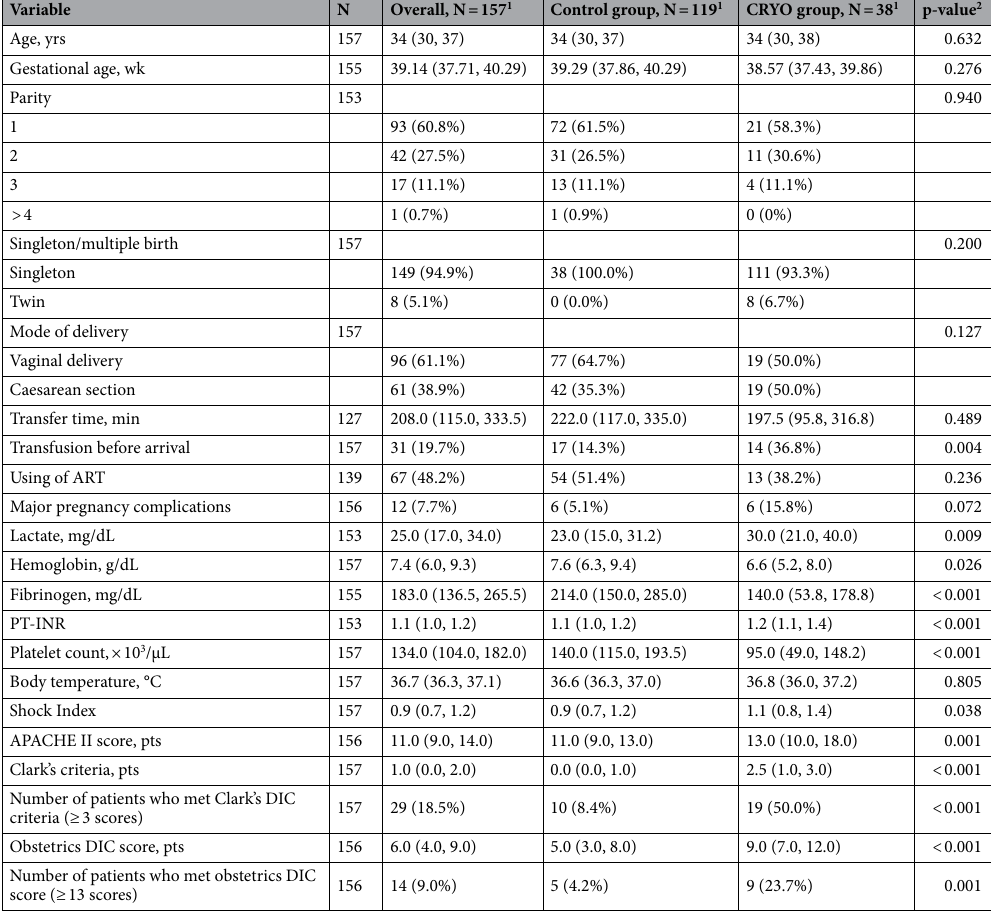
Table 1. Clinical characteristics of the participants. Major pregnancy complications include pregnancy hypertension syndrome, gestational diabetes, and abruptio placentae. Body temperature was recorded as the lowest body temperature during blood transfusion. Shock index was calculated as heart rate divided by systolic blood pressure. CRYO, cryoprecipitate; BMI, body mass index; ART, assisted reproductive technology; APACHE II score, Acute Physiology and Chronic Health Evaluation II score; DIC, disseminated intravascular coagulation. 1 Statistical data are presented as the median (interquartile range) or n (%). 2 Statistical tests performed: Wilcoxon rank-sum test; Fisher’s exact